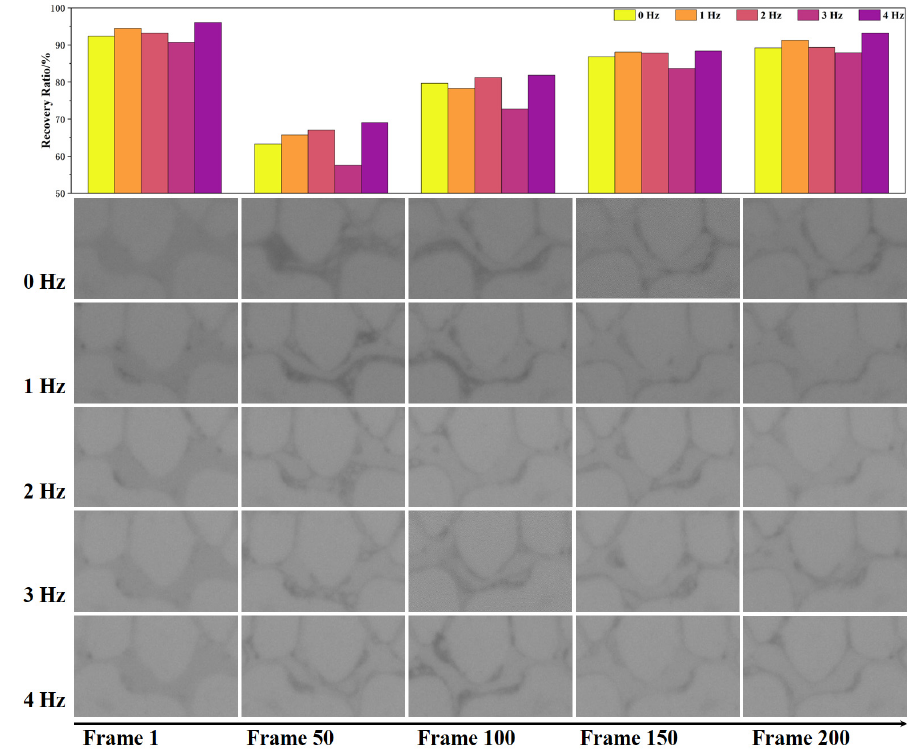
Figure 9. The oil/water distribution images in Block 4 and recovery factor cluster plots when the amplitude is 0.01 mL/min.